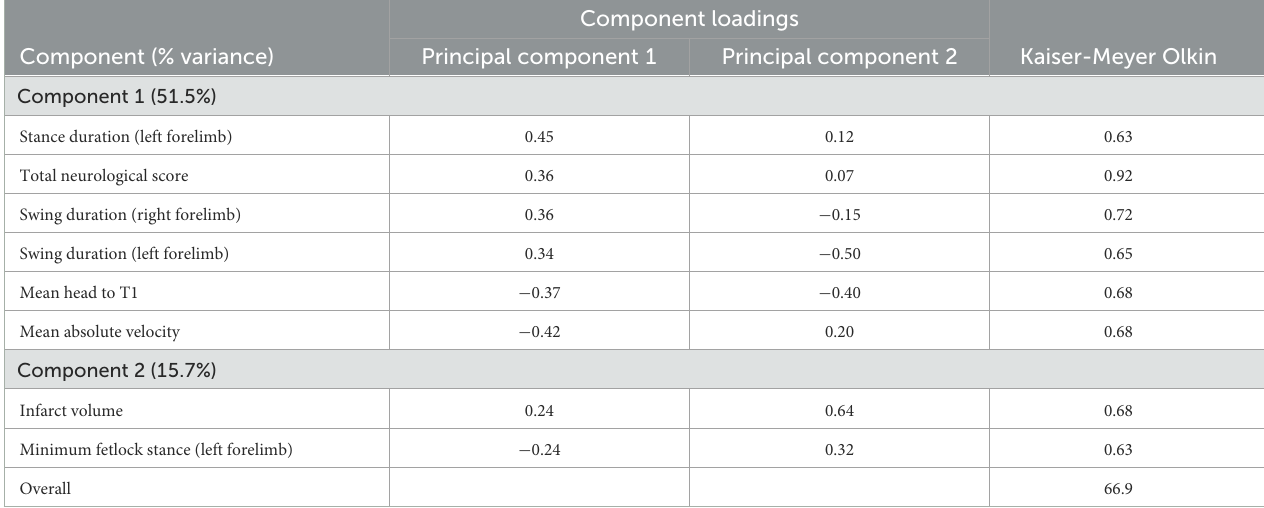
TABLE 3 Component loadings and KMO values for all variables included in the